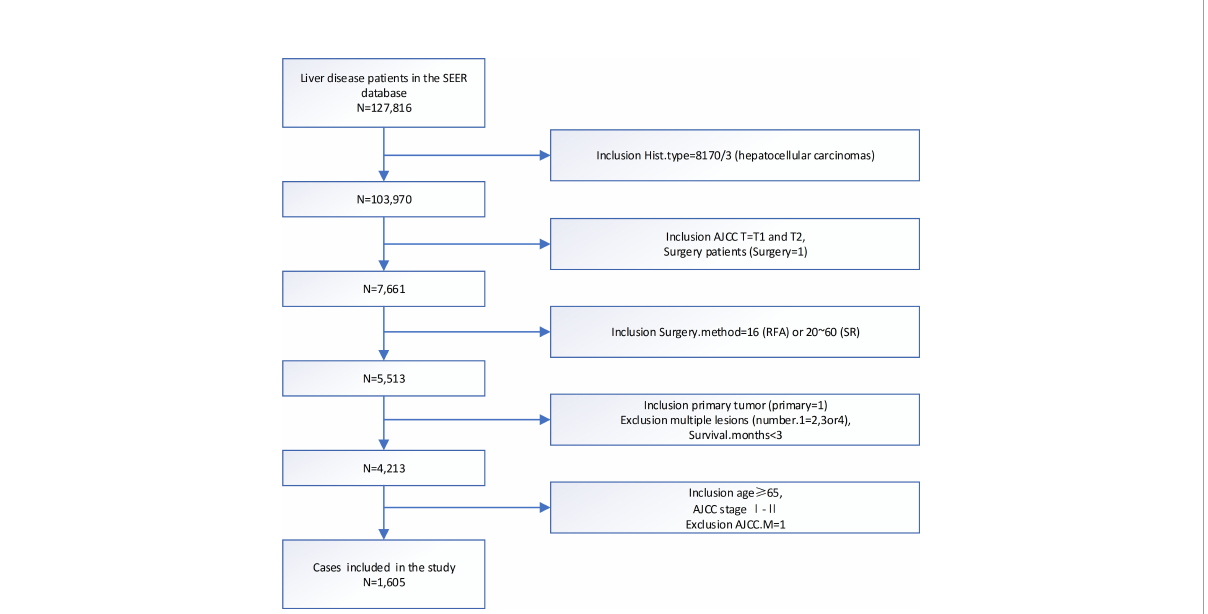
FIGURE 1 Flowchart of patients identi fi ed in this study. SEER, end results; N, number; AJCC, American Joint Committee on Cancer; TNM, tumor node